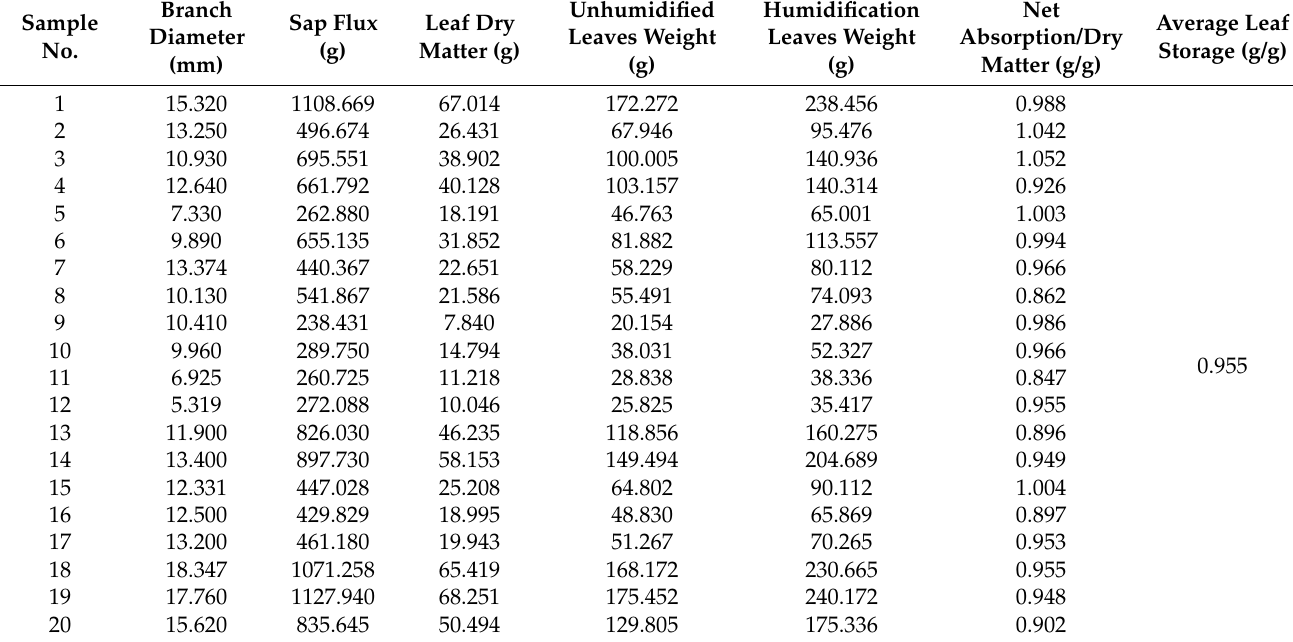
Table 2. Sampling statistics of dry mass weight and sap flow of Tamarisk, 2020.